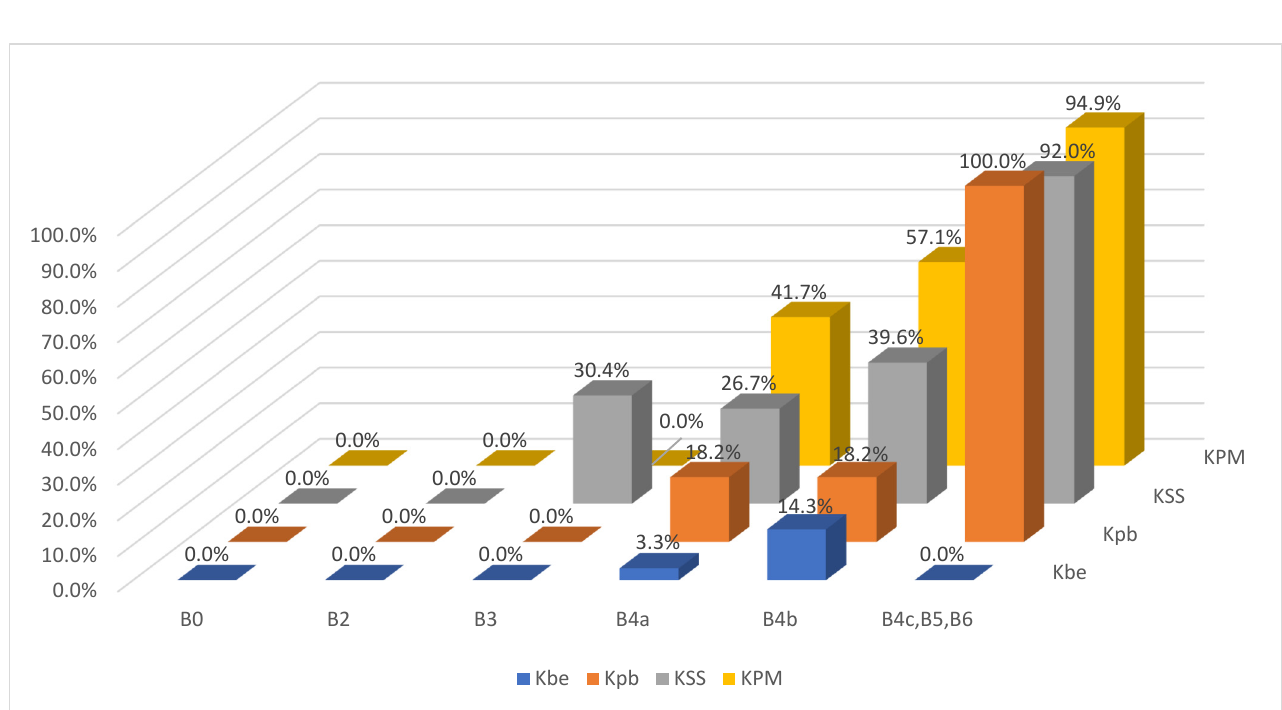
Figure 1. Probability of malignant biopsies for each combination of BI-RADS and KOIOS score. Table 3. Correlation of BI-RADS and KOIOS results against pathology diagnosis.